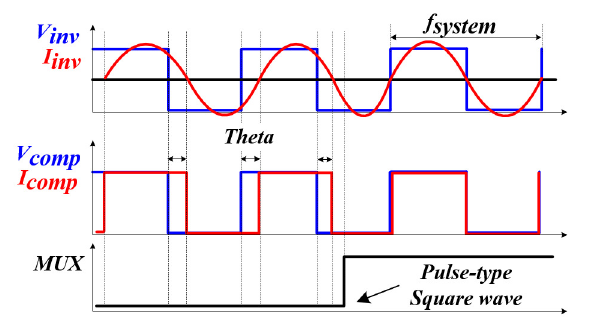
Figure 12. Block diagram of the proposed resonance tracking method.